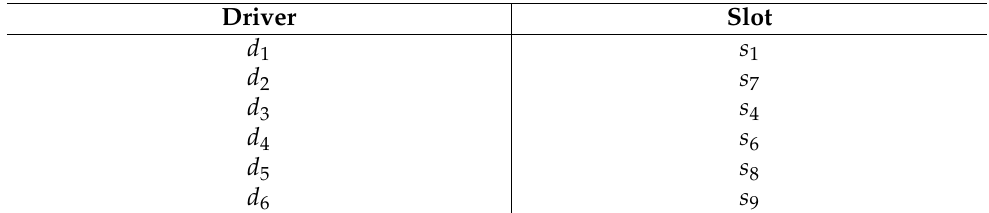
Table 6. Resulting set of the running